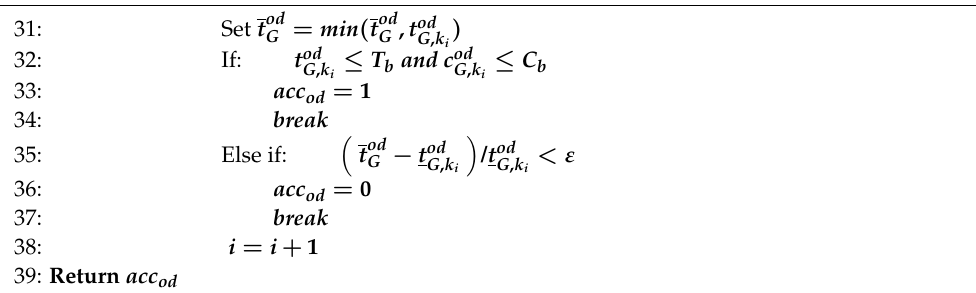
Algorithm 1 The reliability boundary convergence